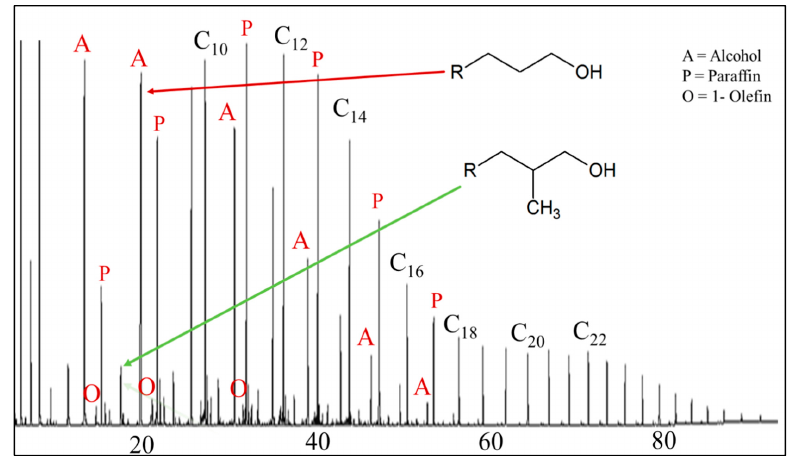
Figure 19. A chromatographic picture of a ceria support cobalt catalyst. The x-axis is retention time in minutes. Reaction Conditions: 230 °C, 27.6 bar, WHSV = 0.5, and H 2 /CO = 2.